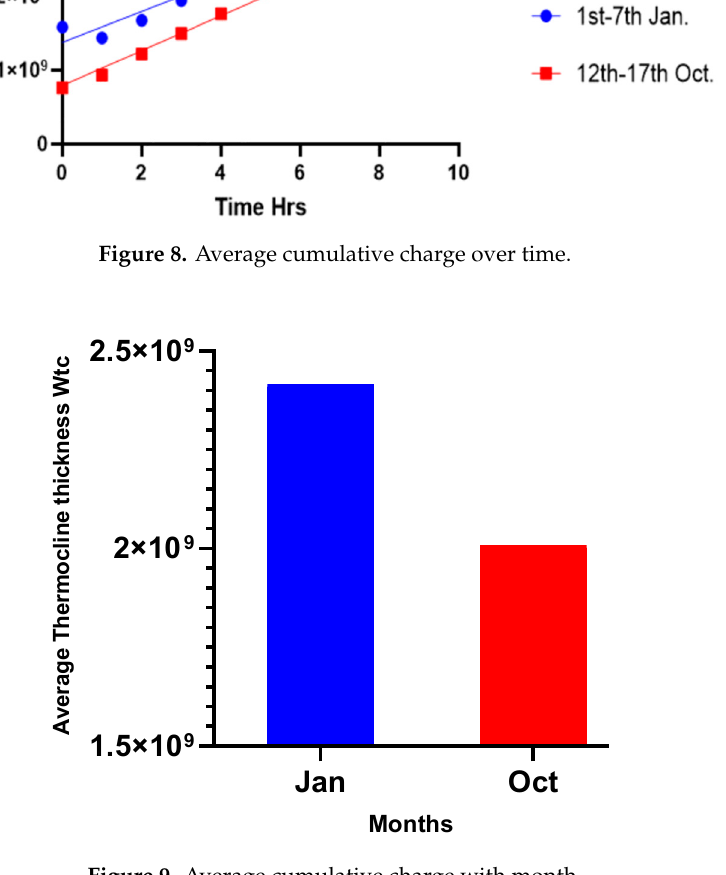
Figure 10. The plot of average Half Figure of Merit (½ FOM) with charging hours.